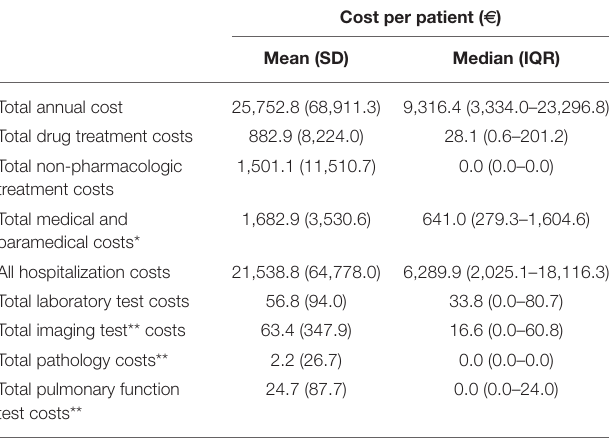
Table 2 . The most commonly used drug treatments were glucocorticoids (74.1%), MMF (21.2%) and azathioprine (10.2%) ( Supplementary Table 6 ). The annual mean costs ( ± SD) per patient for drug treatments during the follow-up were e 883 ( ± 8,224) ( Table 2 ).